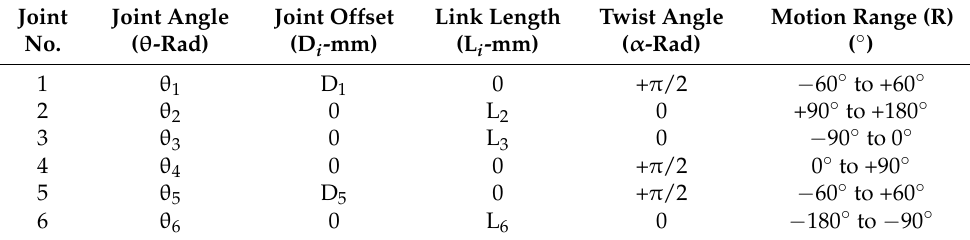
Table 2. D-H Table 2. D-H parameters.